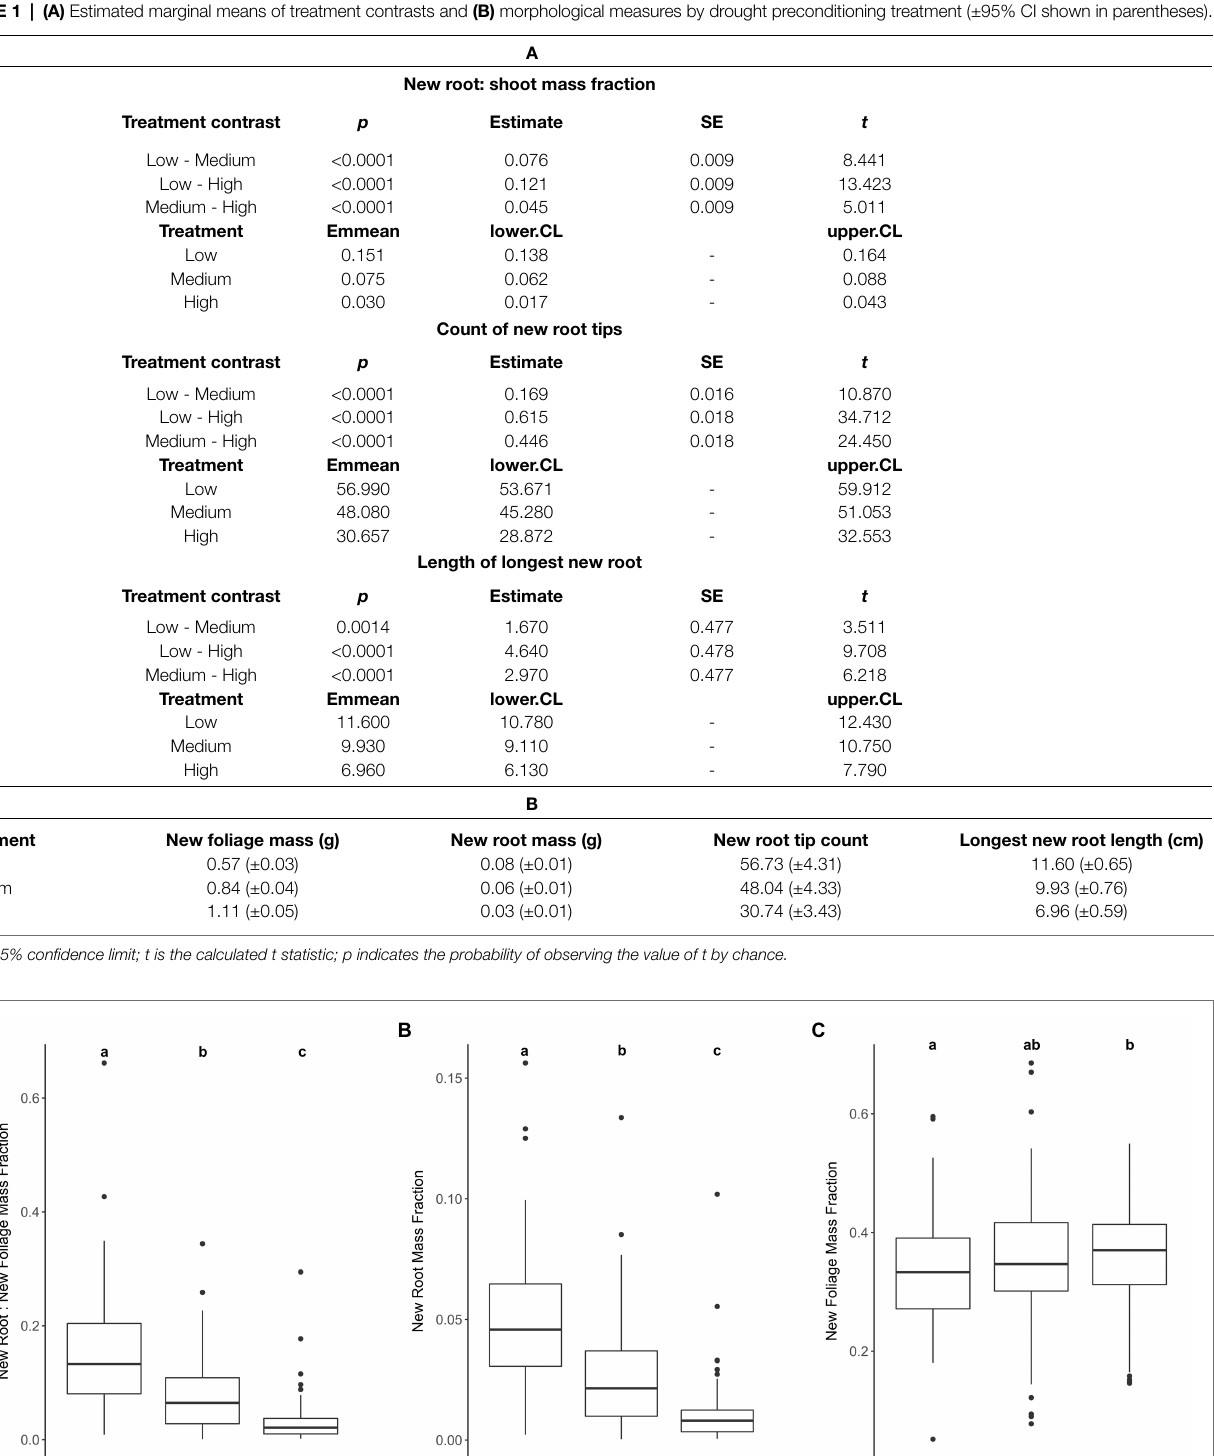
TABLE 1 | (A) Estimated marginal means of treatment contrasts and (B) morphological measures by drought preconditioning treatment (±95% CI shown in